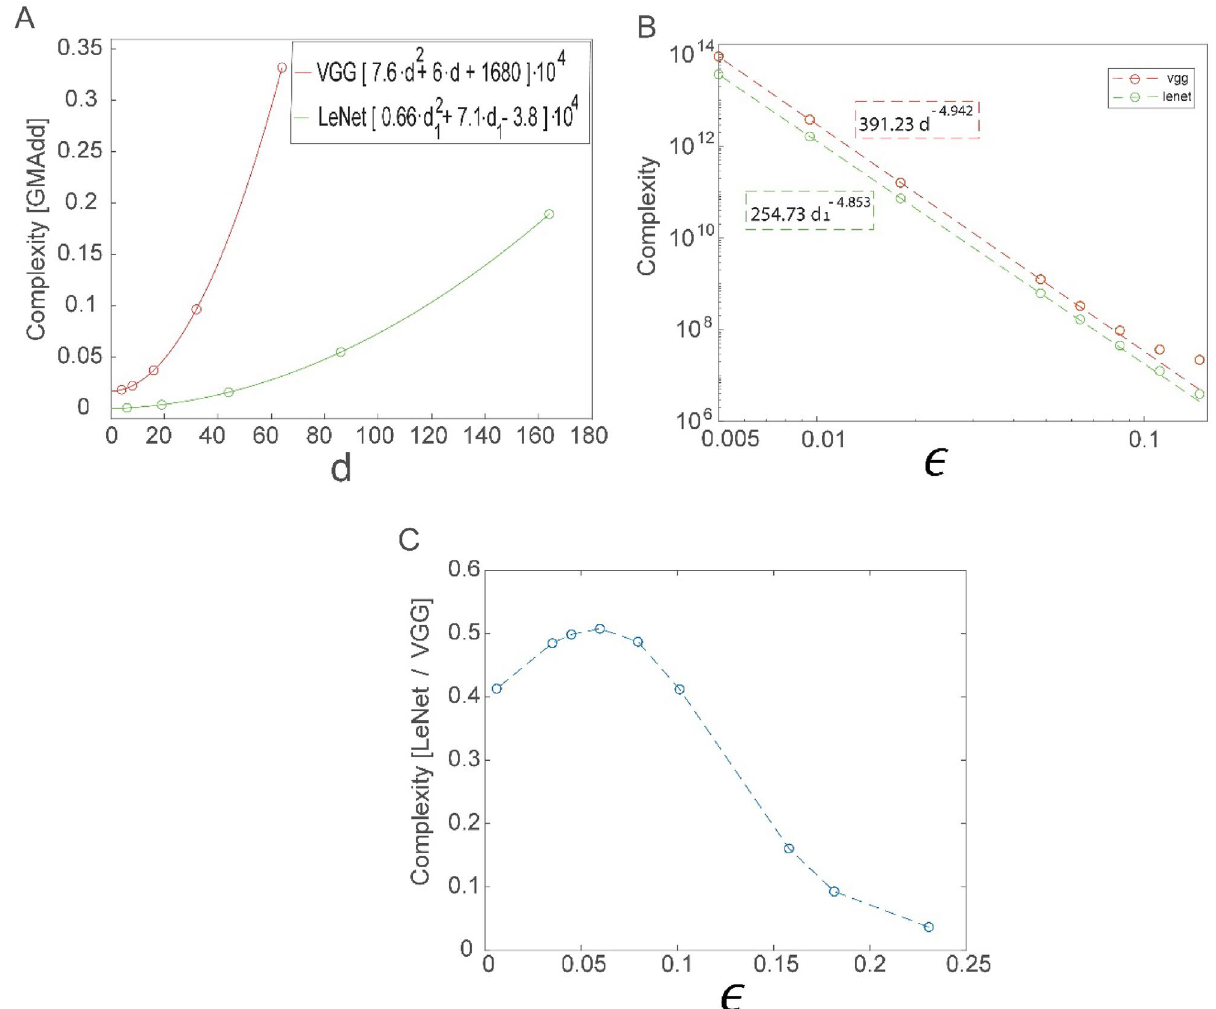
Figure 3. A comparison of learning complexity between generalized LeNet and VGG-16 architectures. ( A ) Complexity of a feedforward and BP step for a single input of LeNet (green) and VGG-16 (red) measured for several d ( d 1 ) values (open circles) and the quadratic polynomial fits. Complexity is measured in Giga multiplication-add operations (GMAdd). ( B ) Complexity as a function of ǫ( d ) for LeNet (green) and VGG-16 (red) for several values of small ǫ (open circles) obtained from the power-law scaling (Figs. 1B, 2B) and the fitted power-law scaling (in dashed boxes), obtained from the last three small values of ǫ (dashed lines). ( C ) The ratio between the complexity of LeNet and VGG-16 for several values ǫ (open circles connected by a dashed line), obtained from the extrapolated ǫ( d 1 ) and ǫ( d ) for LeNet and VGG-16 (Figs. 1B, 2B), respectively, and a direct measure of the complexity 25,26 (Supplementary